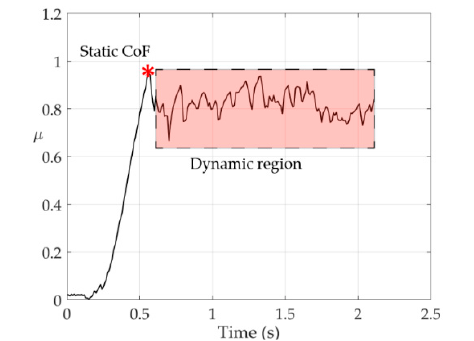
Figure 5. A typical CoF-time trace from the step experiments. The red star indicates the static CoF.